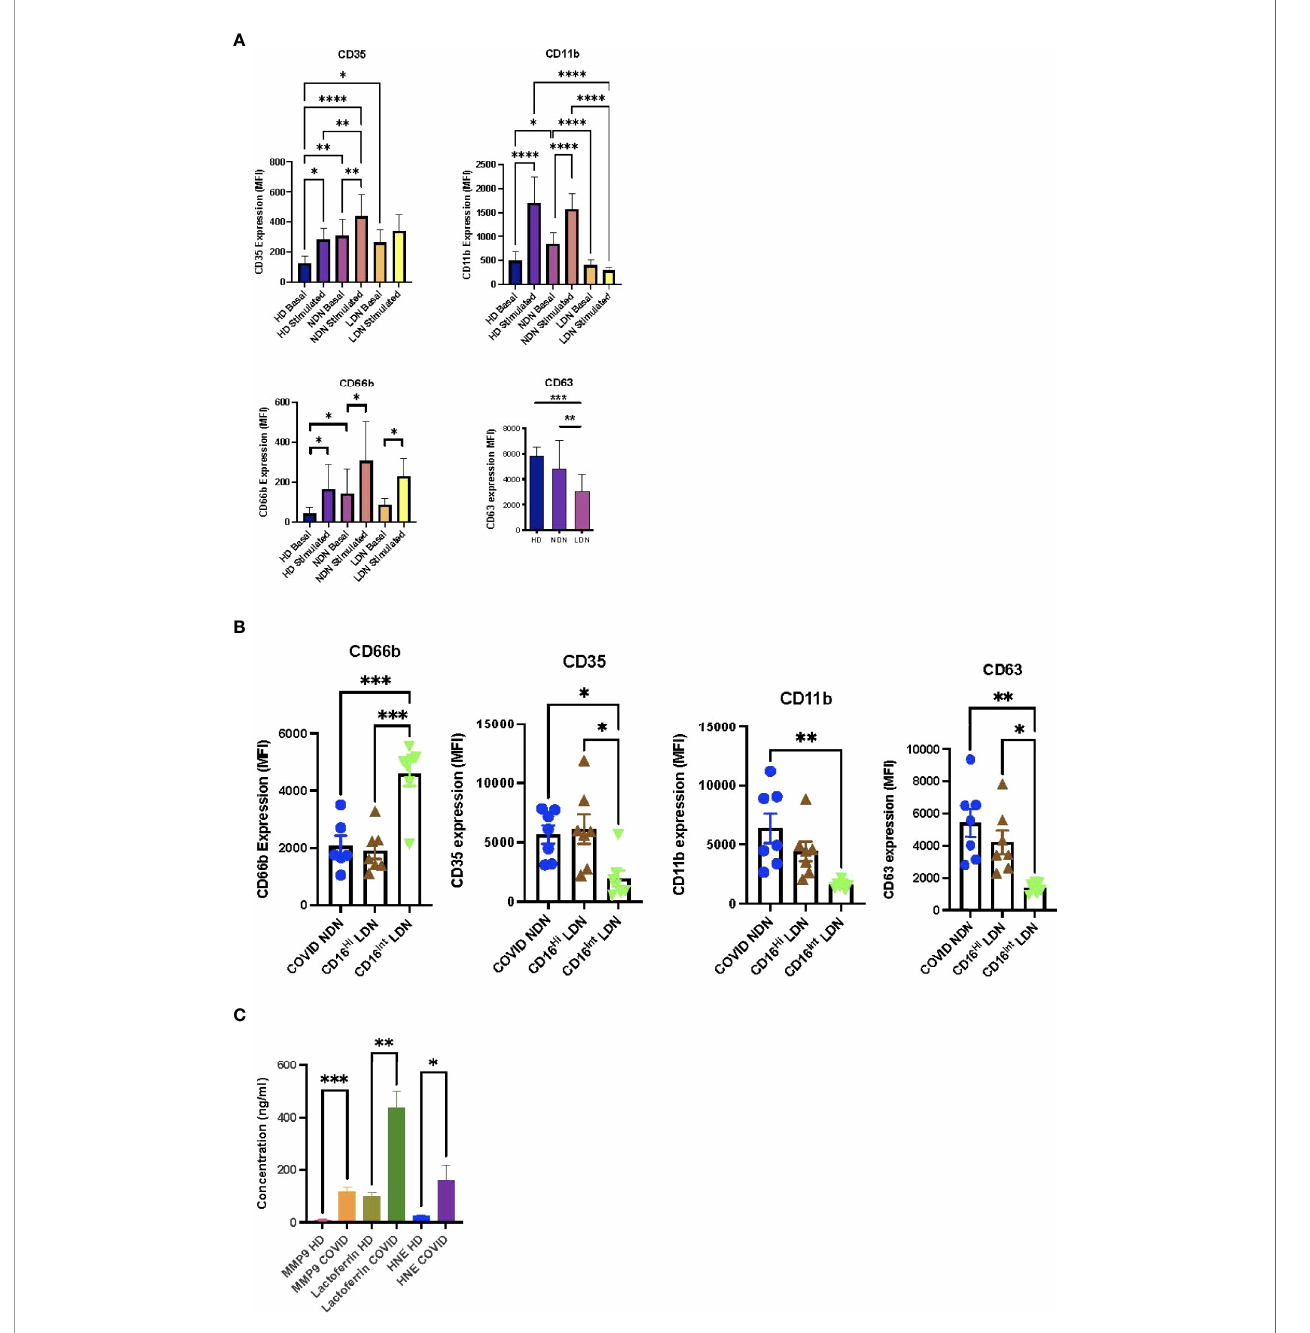
FIGURE 2 | Differential degranulation by neutrophil subsets from COVID-19 patients. (A) Basal and stimulated (TNF a 2 ng/ml + fMLF 300 nM) expression of markers for secretory vesicles (CD35), gelatinase granules (CD11b), speci fi c granules (CD66b), and azurophilic granules (CD63) on COVID NDN (n=11-15), COVID LDN (n=11-15), and HD NDN (n=8-9). Results are expressed as mean ± SEM of mean fl uorescent intensity (MFI). *p < 0.05, **p < 0.01, ***p < 0.001, ****p < 0.0001. (B) Comparison of basal expression of CD35, CD11b, CD66b, and CD63 on COVID NDN, CD16 Hi LDN, and CD16 Int LDN (n=7). Results are expressed as mean ± SEM of MFI. *p < 0.05, **p < 0.01, ***p < 0.001. (C) Plasma levels of MMP9, lactoferrin, and human neutrophil elastase in plasma from HD (n=10) and COVID-19 (n=10-25). Results expressed as mean + SEM in ng/ml. *p < 0.05, **p < 0.01, ***p <